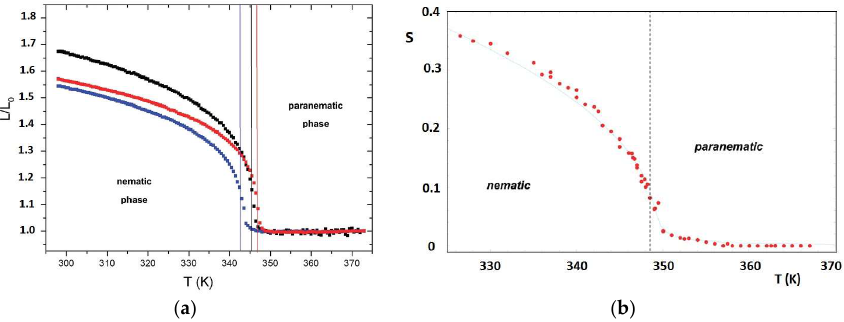
Figure 11. ( a ) Thermo-mechanical behavior of the standard monodomain LCE film (blue